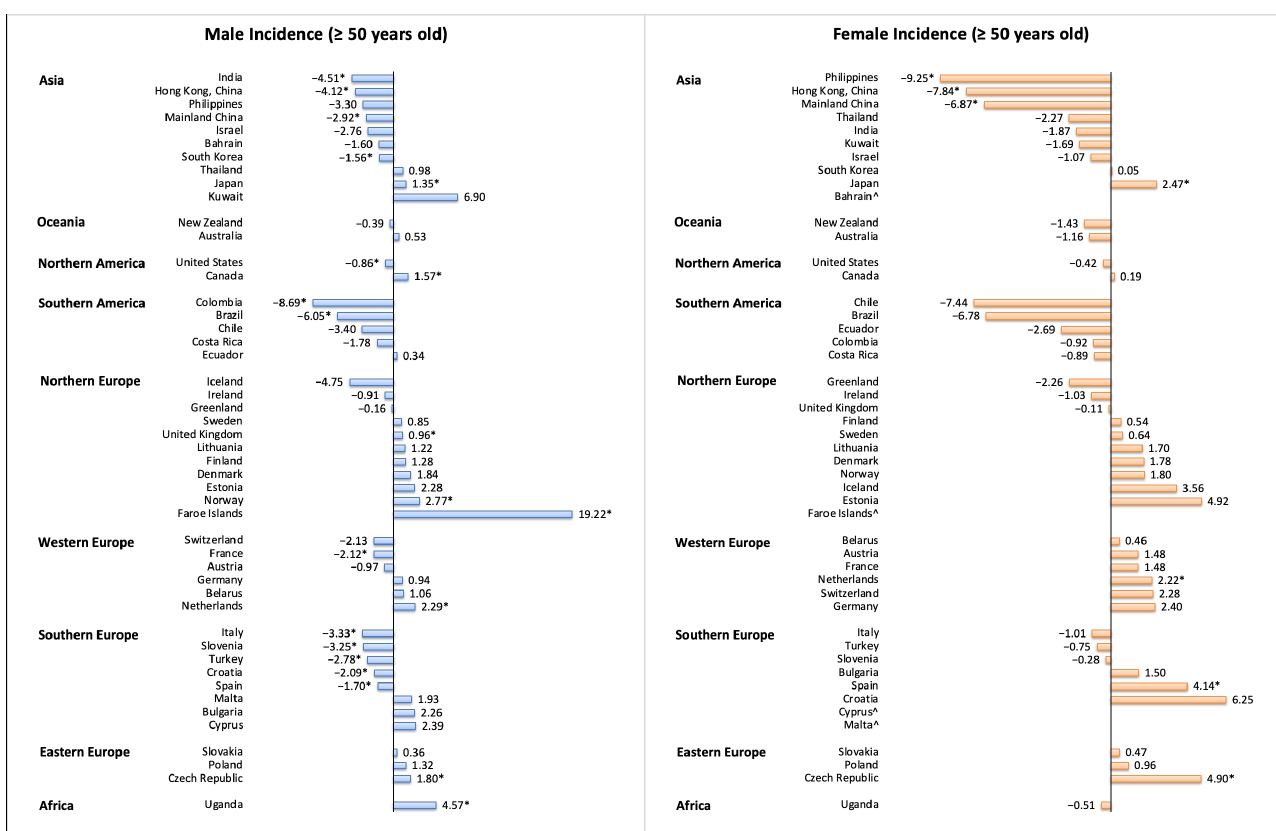
Figure 6. The AAPC of the incidence of esophageal cancer in individuals aged ≥ 50 years